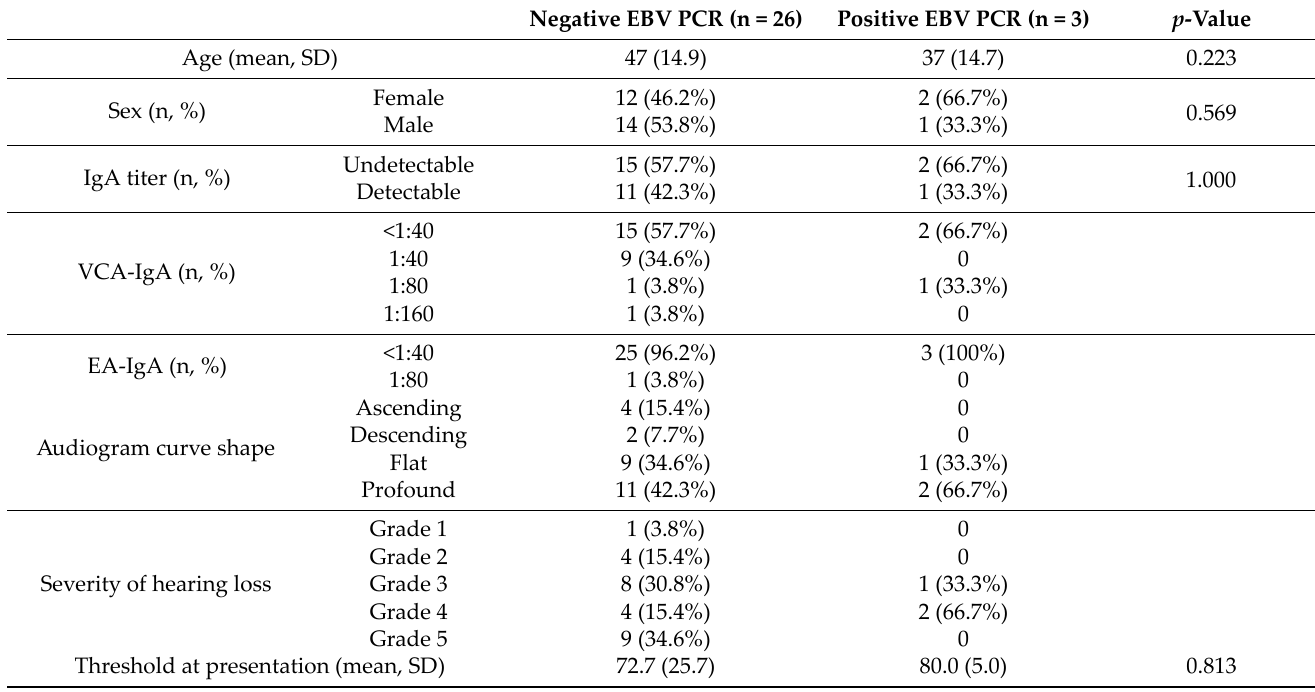
Table 1. Baseline